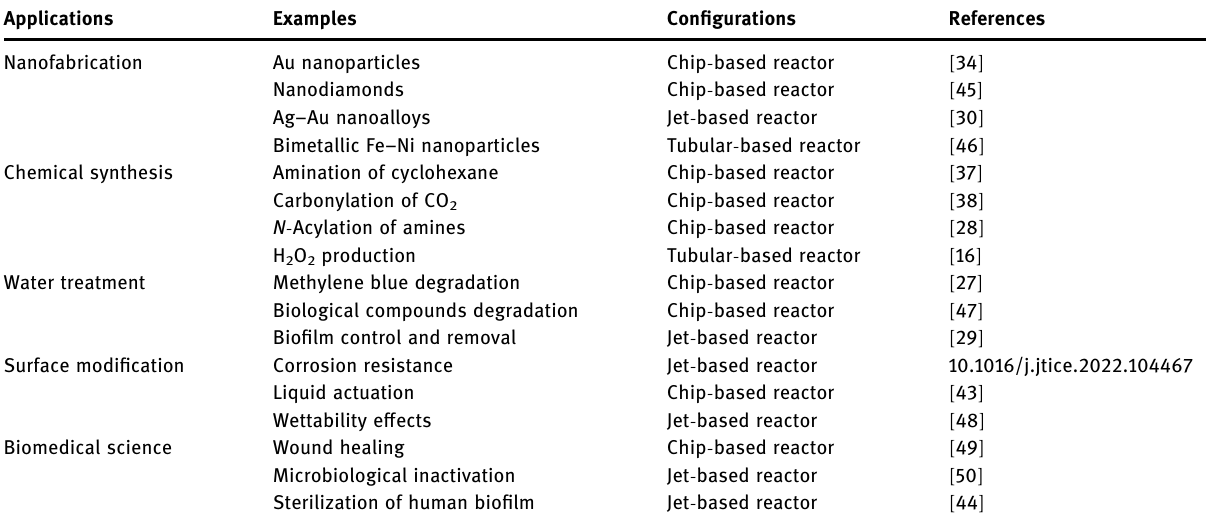
Table 1: Typical examples of micro fl uidic plasma in diverse fi